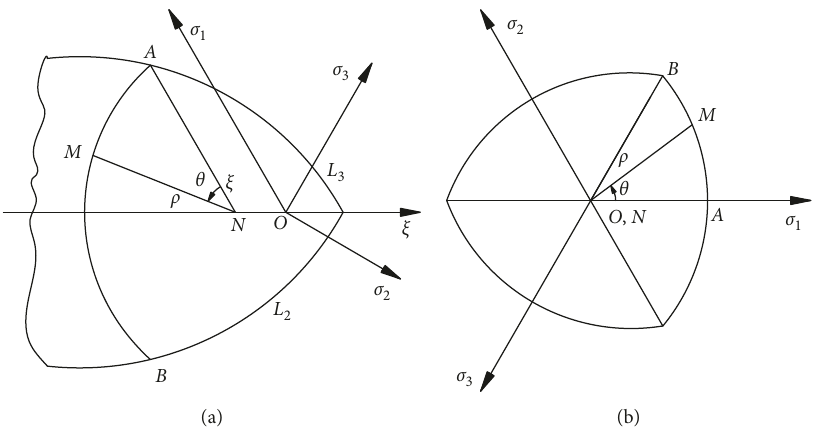
Figure 11: Parabolic three-parameter strength